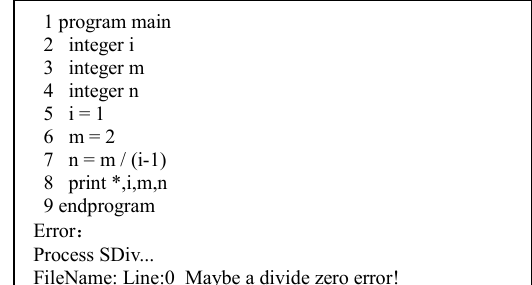
Figure 6 Pointer overflow example